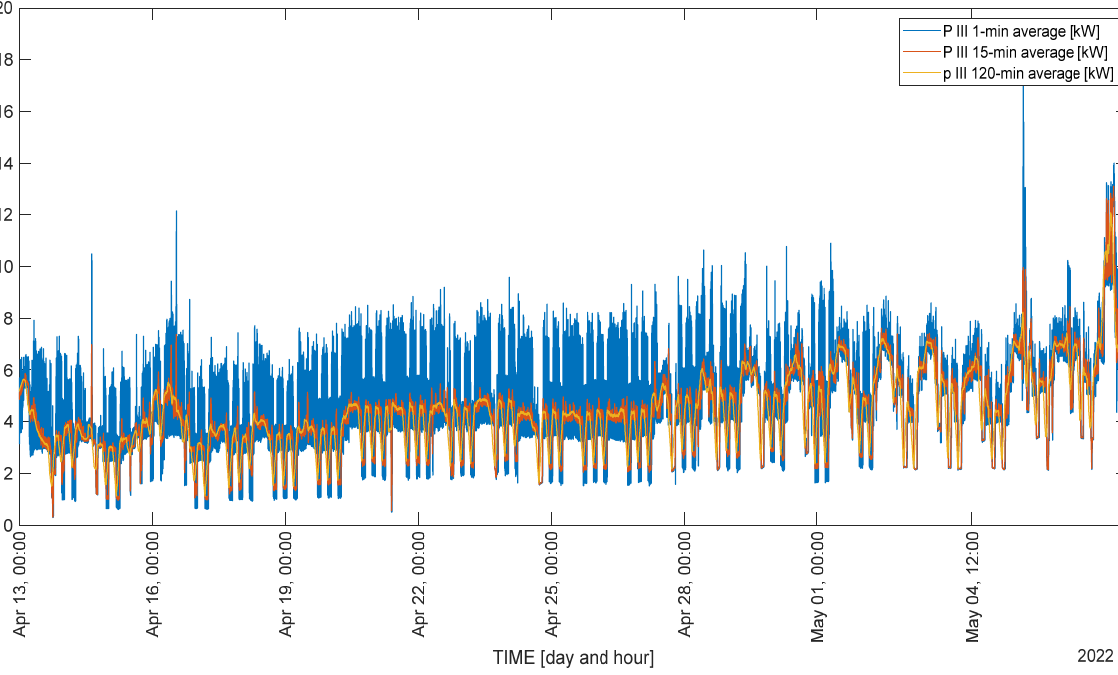
Figure 5. Three-phase active power as a function of time in the 2nd stage of the cycle.